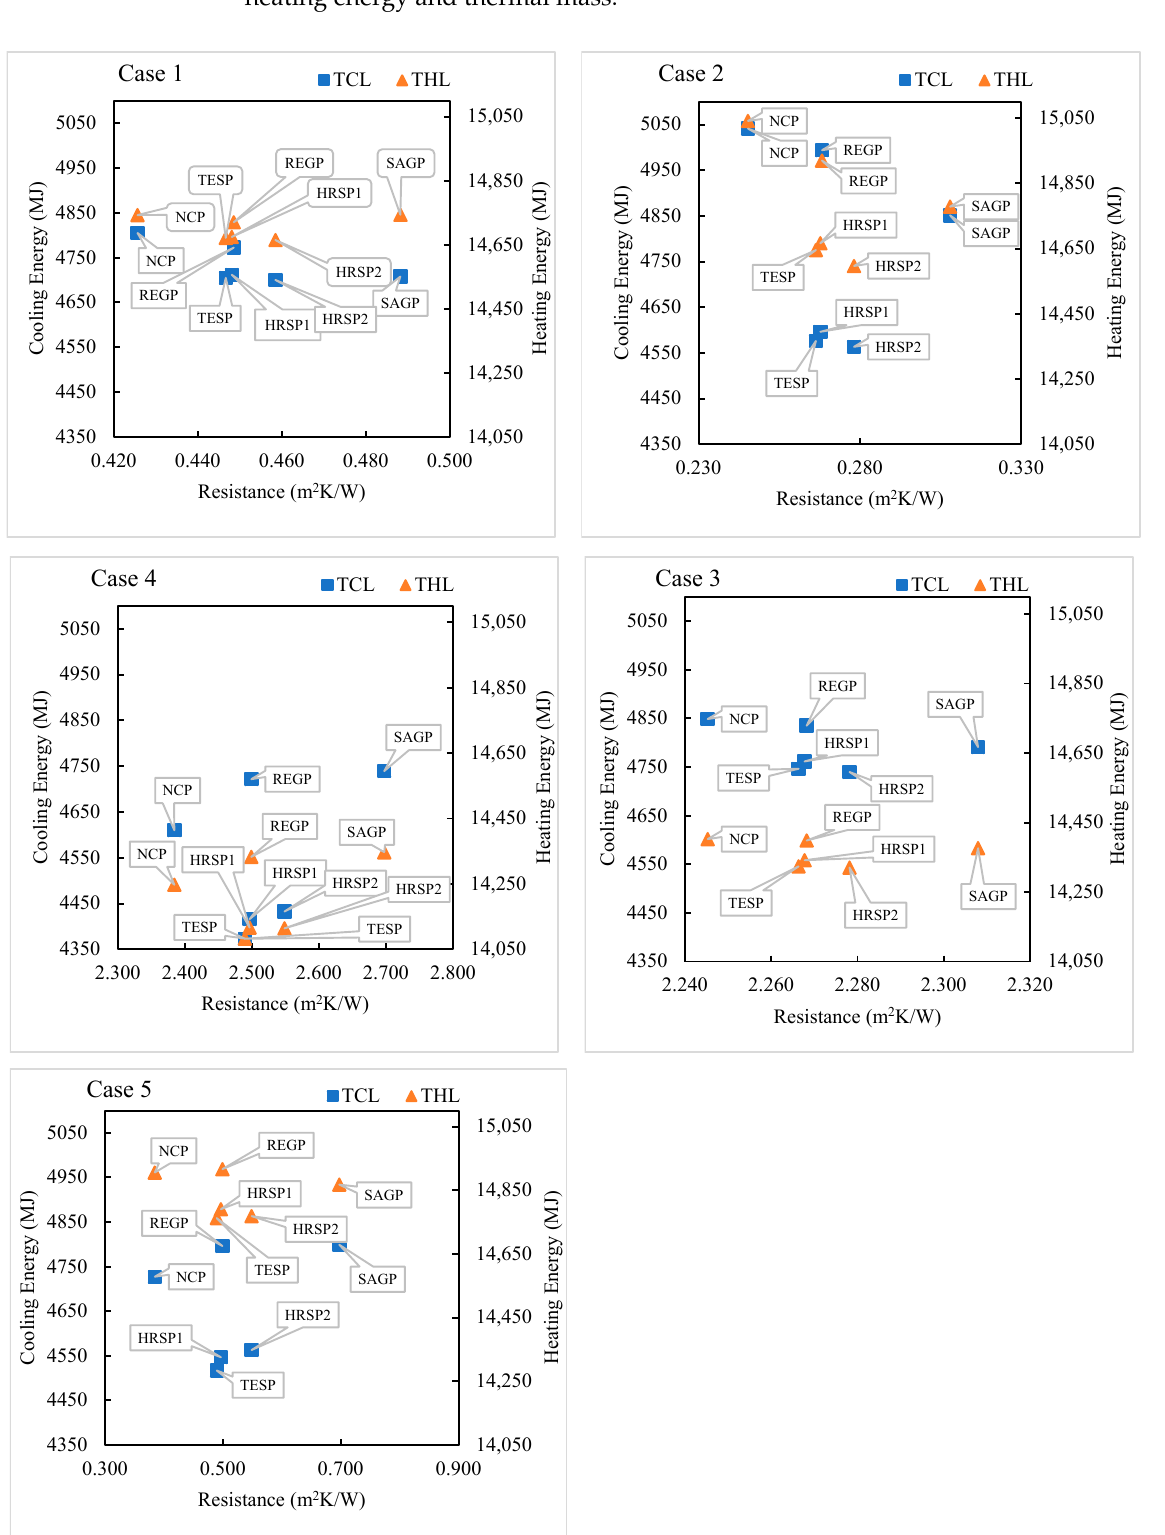
Figure 11. Effect of external wall thermal resistance on operation energy consumption (cooling and heating).